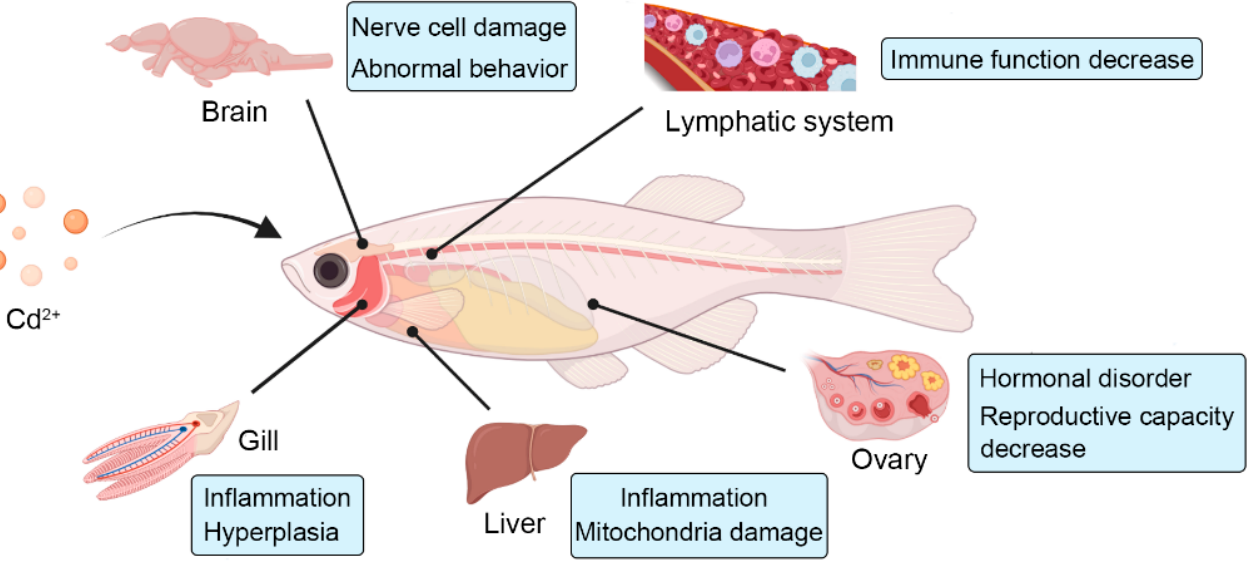
Figure 1. Schematic diagram of toxic effects of Cd on fish organs.